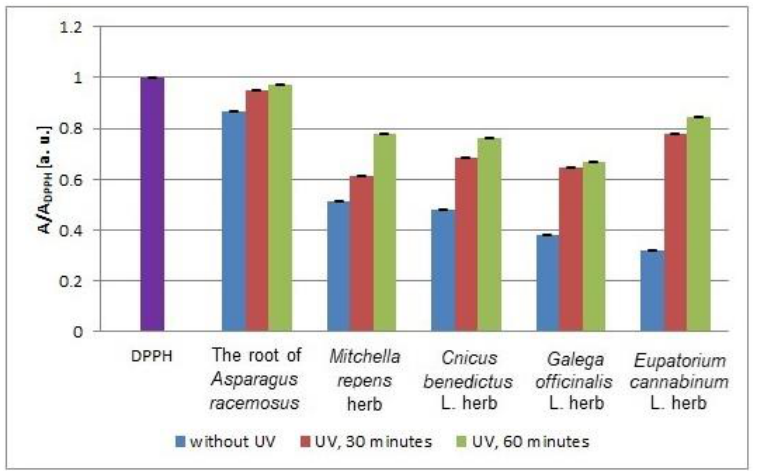
Figure 11. Comparison of the relative amplitudes (A/A DPPH ) [±0.02 a. u.] of the EPR spectra of DPPH free radicals interacting with infusions of the root of Asparagus racemosus and Mitchella repens herb, Cnicus benedictus L. herb, Galega officinalis L. herb, and Eupatorium cannabinum L. herb for 33 min. A—amplitude of the EPR line of DPPH free radicals in contact with the tested samples. A DPPH —amplitude of the EPR line of DPPH free radicals in the reference solution. For the reference solution, the relative amplitude (A/A DPPH ) takes a value of 1. Data for the infusions obtained from the plant materials exposed to UVA radiation for 30 and 60 min. Data for the infusions of the plant material that was not exposed to UVA radiation are also given.